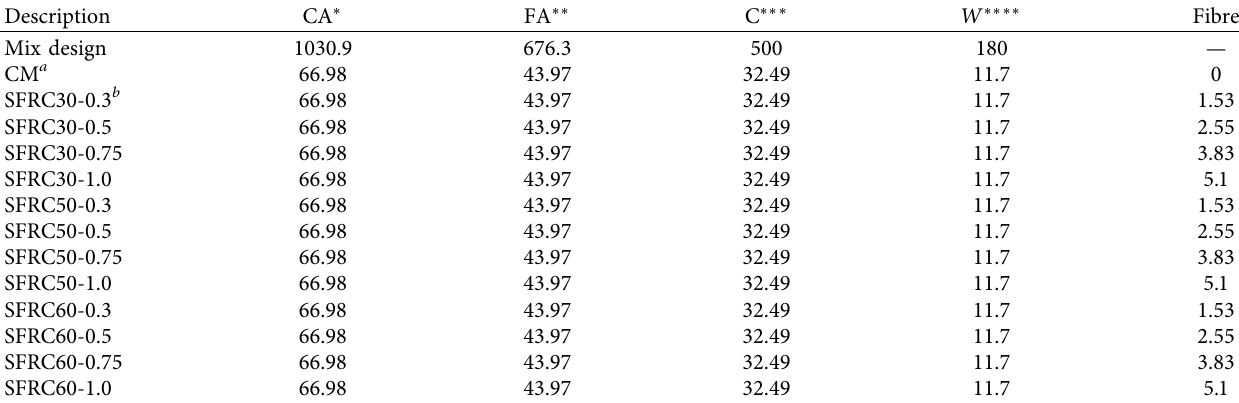
Table 5: Concrete design mix (kg/m 3 ).